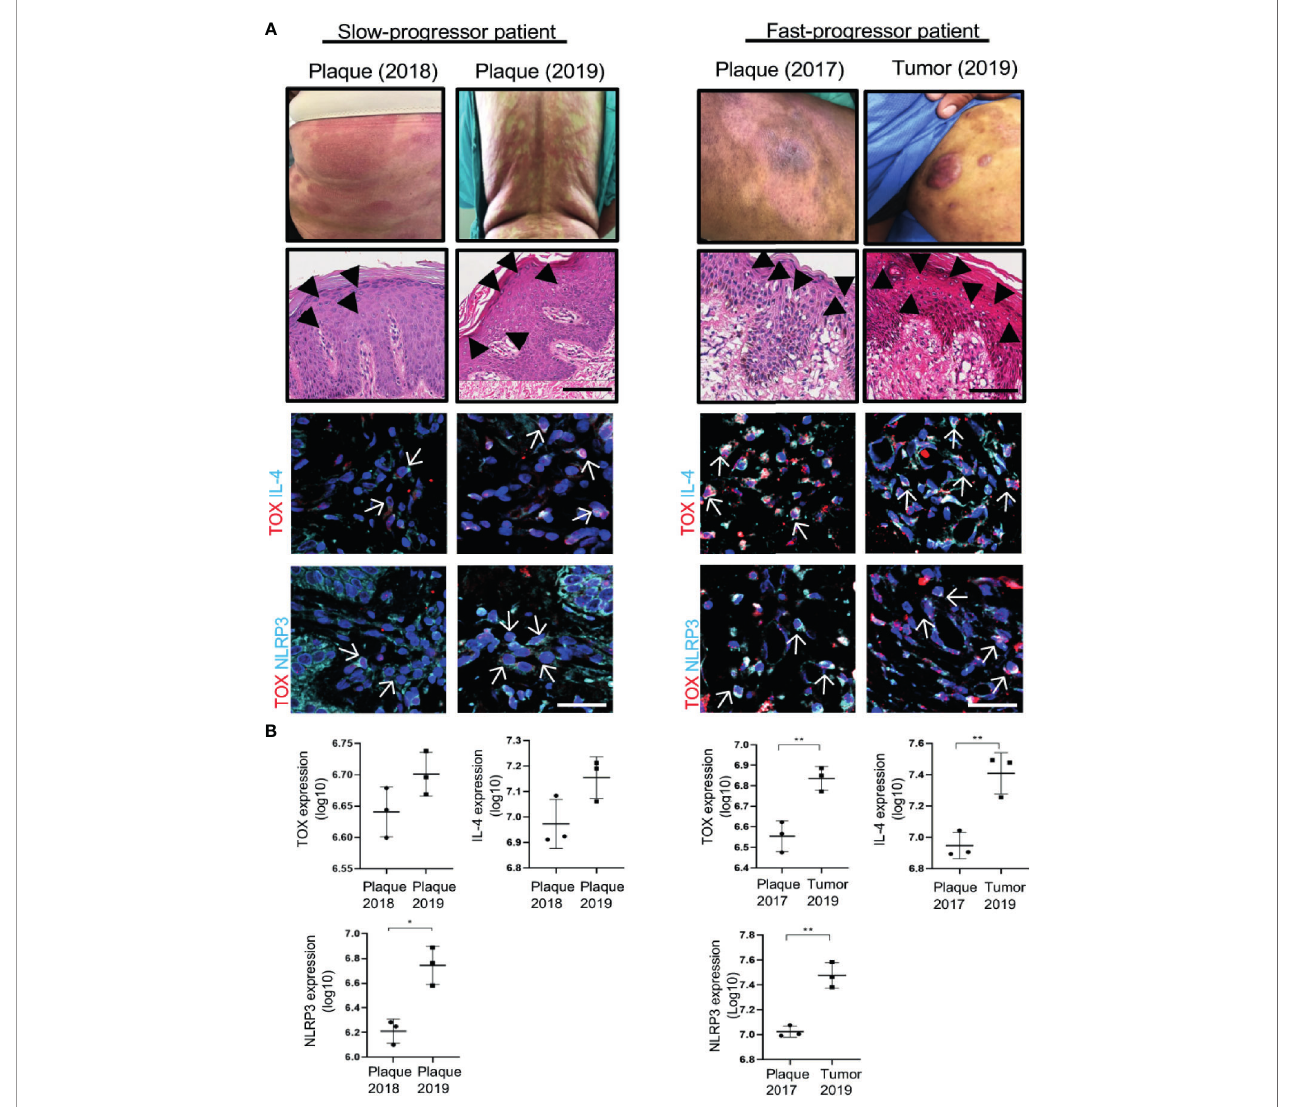
FIGURE 7 | Molecules implicated in the mechanism of IL-4 regulation mediated by NLRP3 are associated with CTCL progression. (A) Clinical photographs of the lesions from representative slow (left) and fast (right) progressor CTCL patients. Hematoxylin-eosin (HE) staining in a slow and fast progressor CTCL patient. Representative immuno fl uorescence images of the expression of TOX (AF-594) and IL-4 (AF-647) (mid panel) and TOX (AF-594) and NLRP3 (AF-647) (bottom panel) in biopsies from representative slow progressor and fast progressor CTCL patients. Quanti fi cation of the total expression of (B) TOX, IL-4 and NLRP3 in the microphotographs of the representative slow progressor and fast progressor patient of CTCL from (A) . Black arrows indicate Pautrier microabscesses, and white arrows indicate coexpression of markers in the different staining. Error bars = SEM. *P < 0.05; **P < 0.01. Scale bar, 20